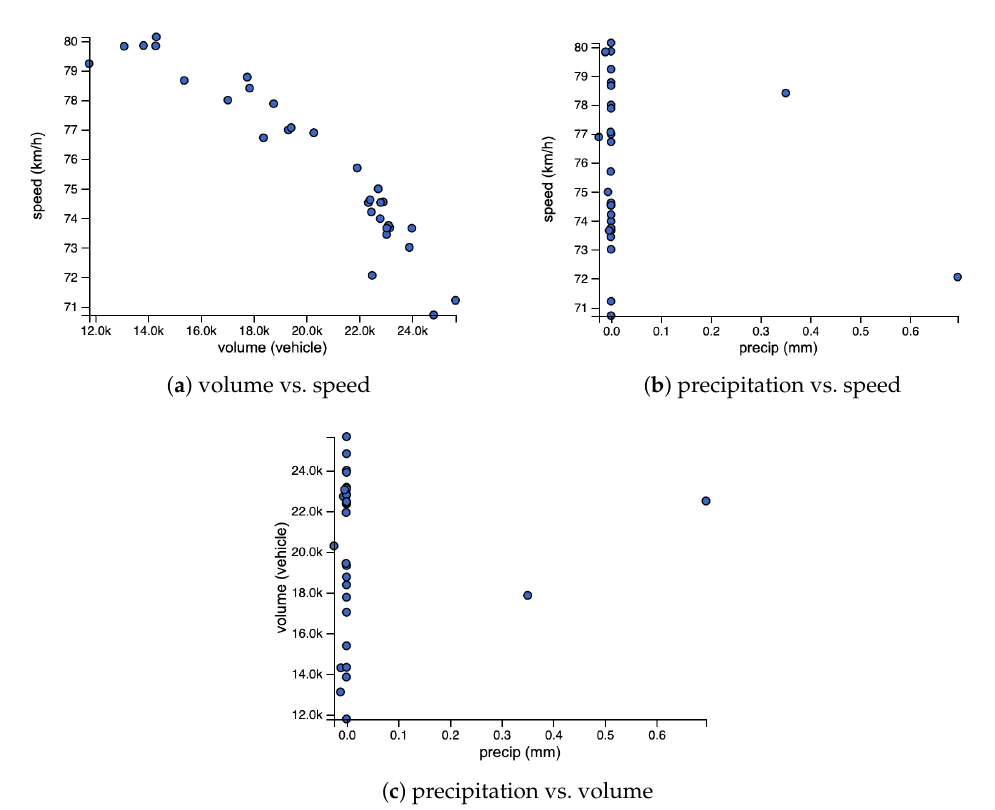
Figure 12. Bivariate plots for TS3 in January